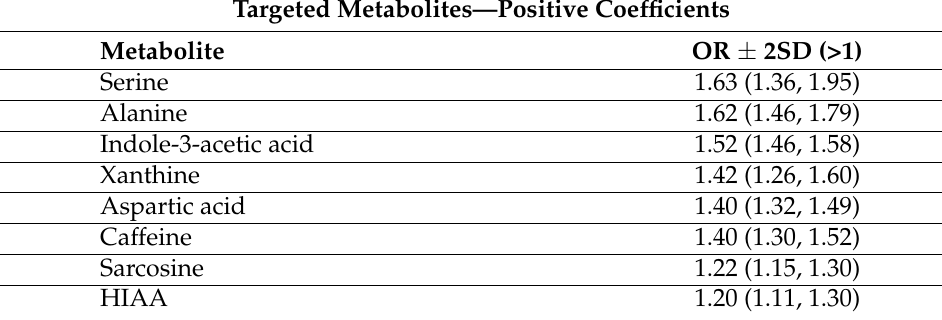
Table 4. Names and OR (associated with a standard deviation increase in concentration) for targeted metabolites retained in all five elastic net models fit on the full data to classify PD patients against AD patients. A metabolite with OR > 1 indicates that higher concentration is associated with AD in our models. Only ORs with magnitude greater than 1.1 or less than 0.9 are shown here. A two standard deviation interval is shown for the OR to quantify variability across the five missing data